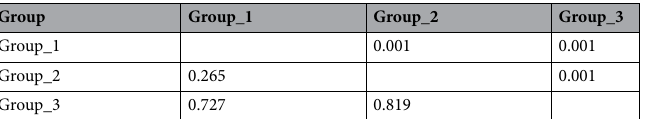
Table 5. Genetic distance (down diagonal) and pair fixation index ( F ST , up diagonal) between three groups inferred by structure